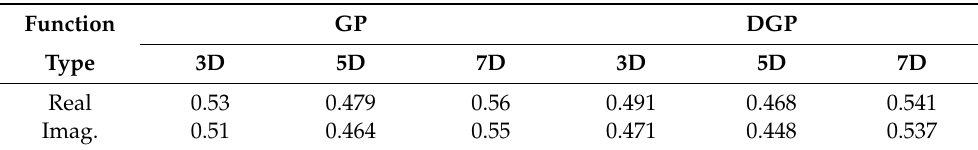
Table 17. Comparison between the GP and DGP CRMSE for real and imaginary part approximations with 3D, 5D and 7D